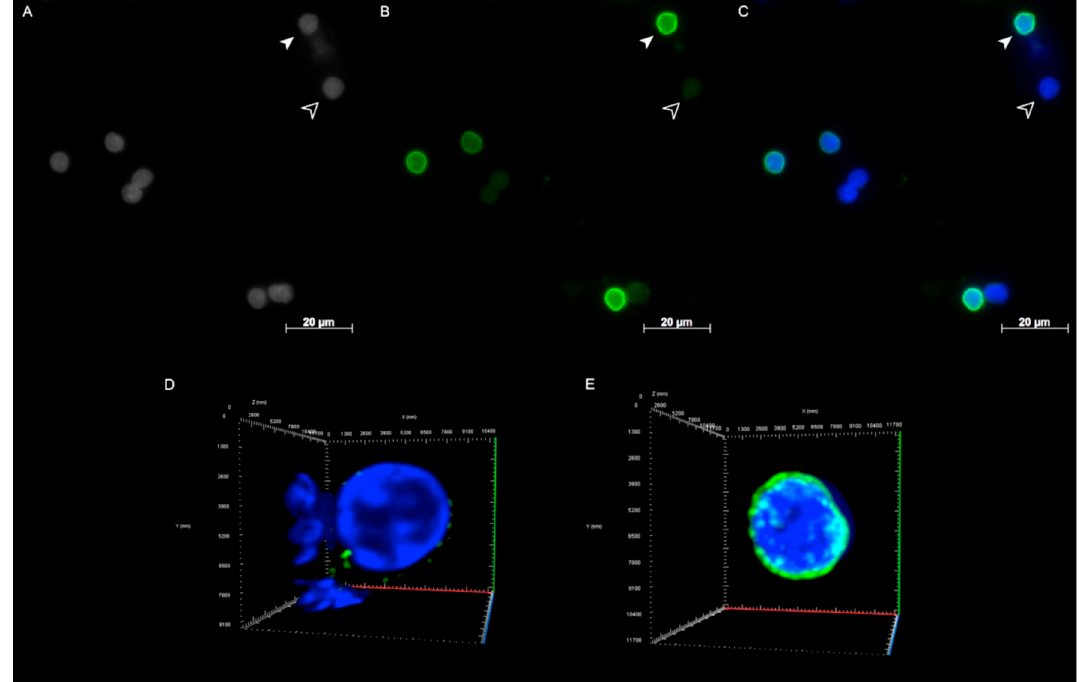
Figure 2. Lamin A/C immunostaining of resting and LPS-activated lymphocytes from peripheral blood (PB) of a healthy donor. ( A ) 2D image of nuclei stained with DAPI (gray scale); ( B ) 2D image of anti-lamin A/C antibody immunostaining (green); ( C ) 2D merged image showing activated lymphocytes with a higher fluorescence intensity lamin A/C signal (solid arrowhead) compared to resting cells (empty arrowhead). Complete 3D reconstitution of a resting ( D ) and an activated ( E ) lymphocyte.